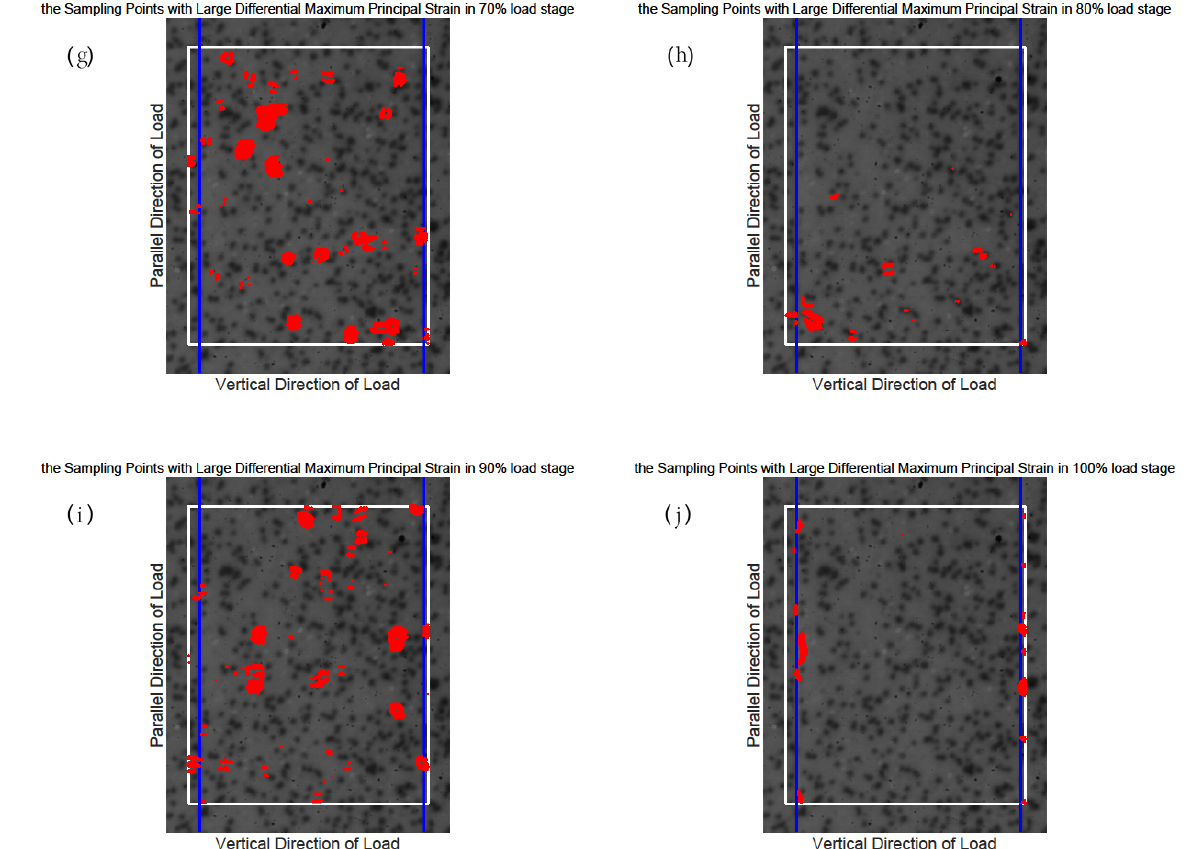
Figure B3. The position of the sampling points with large differential maximum principal strain for sample